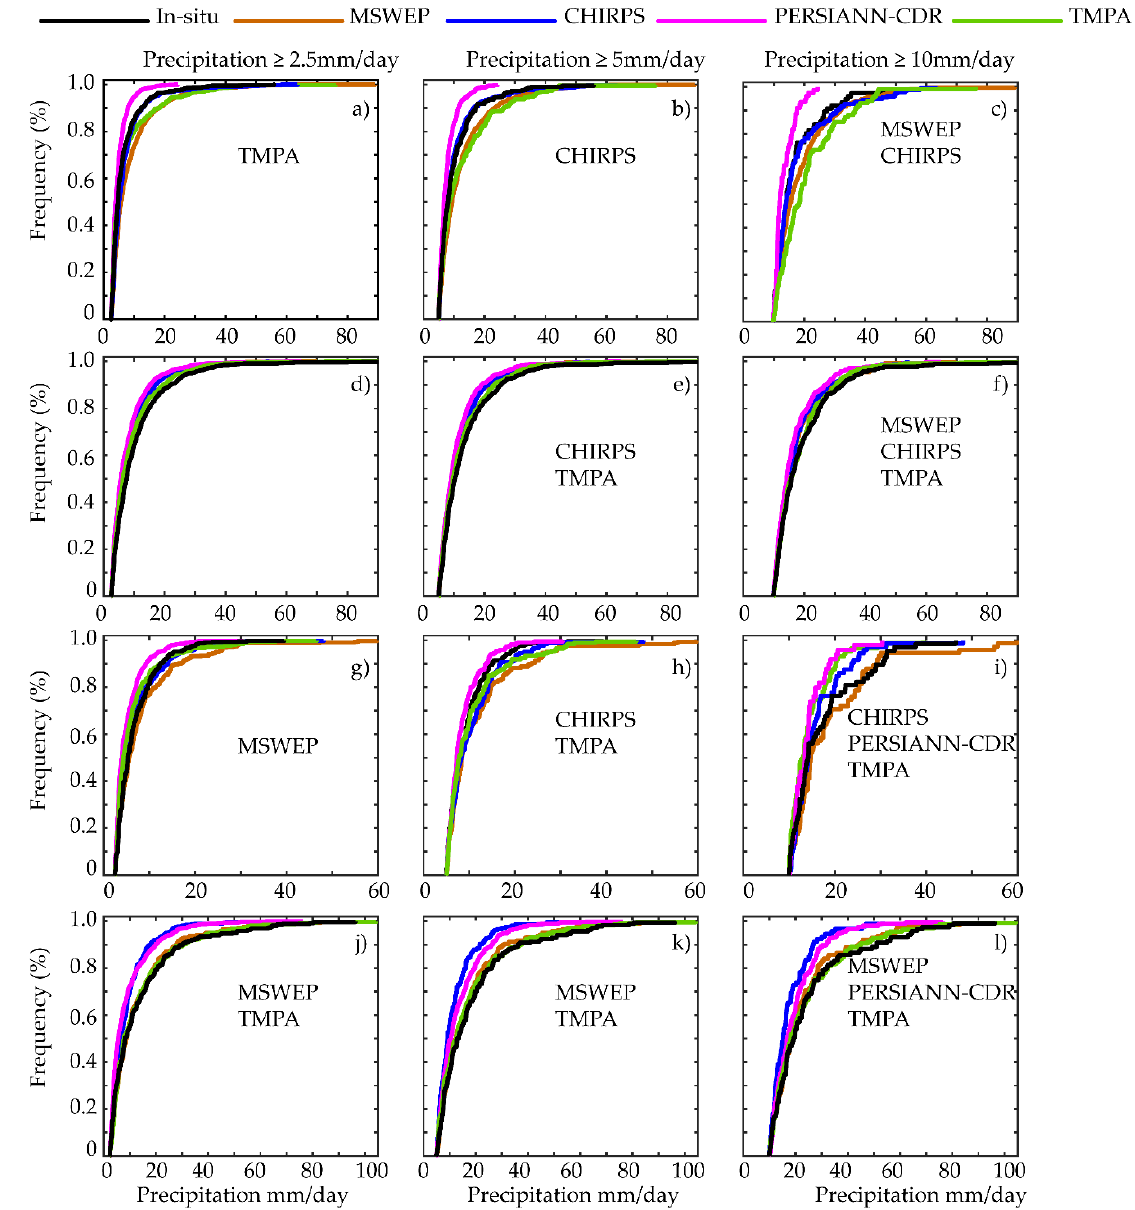
Figure 5. Comparisons of the Empirical Cumulative Distribution Functions (ECDFs) of daily precipitation (with different thresholds: 2.5, 5 and 10 mm/day) for in-situ and GPPs in selected regions. The products with a significantly (95%) similar distribution to the in-situ data based on a Kolmogorov-Smirnov test are given in the respective boxes. ( a–c ), ( d–f ), ( g–i ) and ( j–l ) are equivalent to regions 1, 2, 3 and 4 in Table